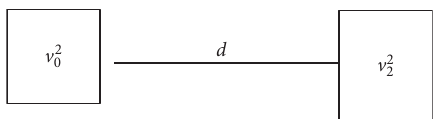
Figure 4: Change from the 1 st point to the 2 nd